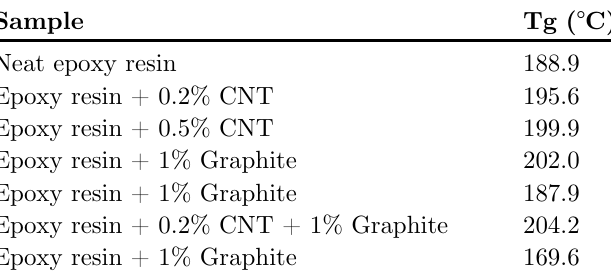
Table 3. T ( ° C)ofepoxyresinincorporatingCNTsand/or g Graphite by